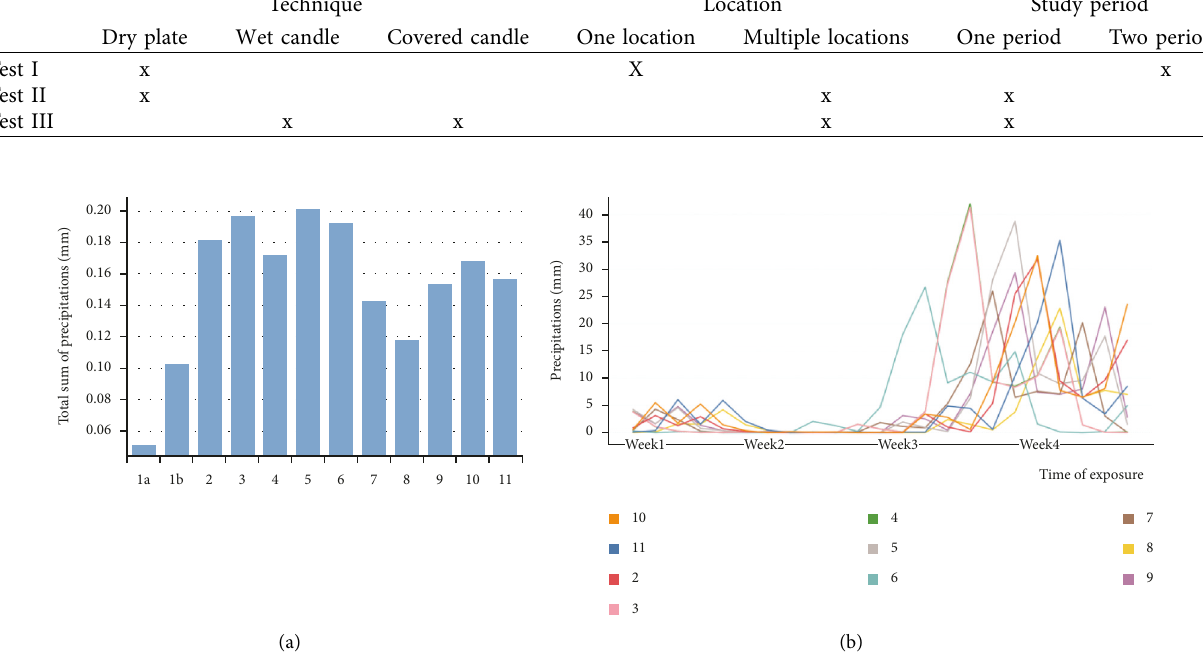
Figure 7. The upper part of the figure shows the chloride deposition results during the first time interval (left) and the second time interval (right). Below, the wind rose during each study period is included. The blue dots represent the